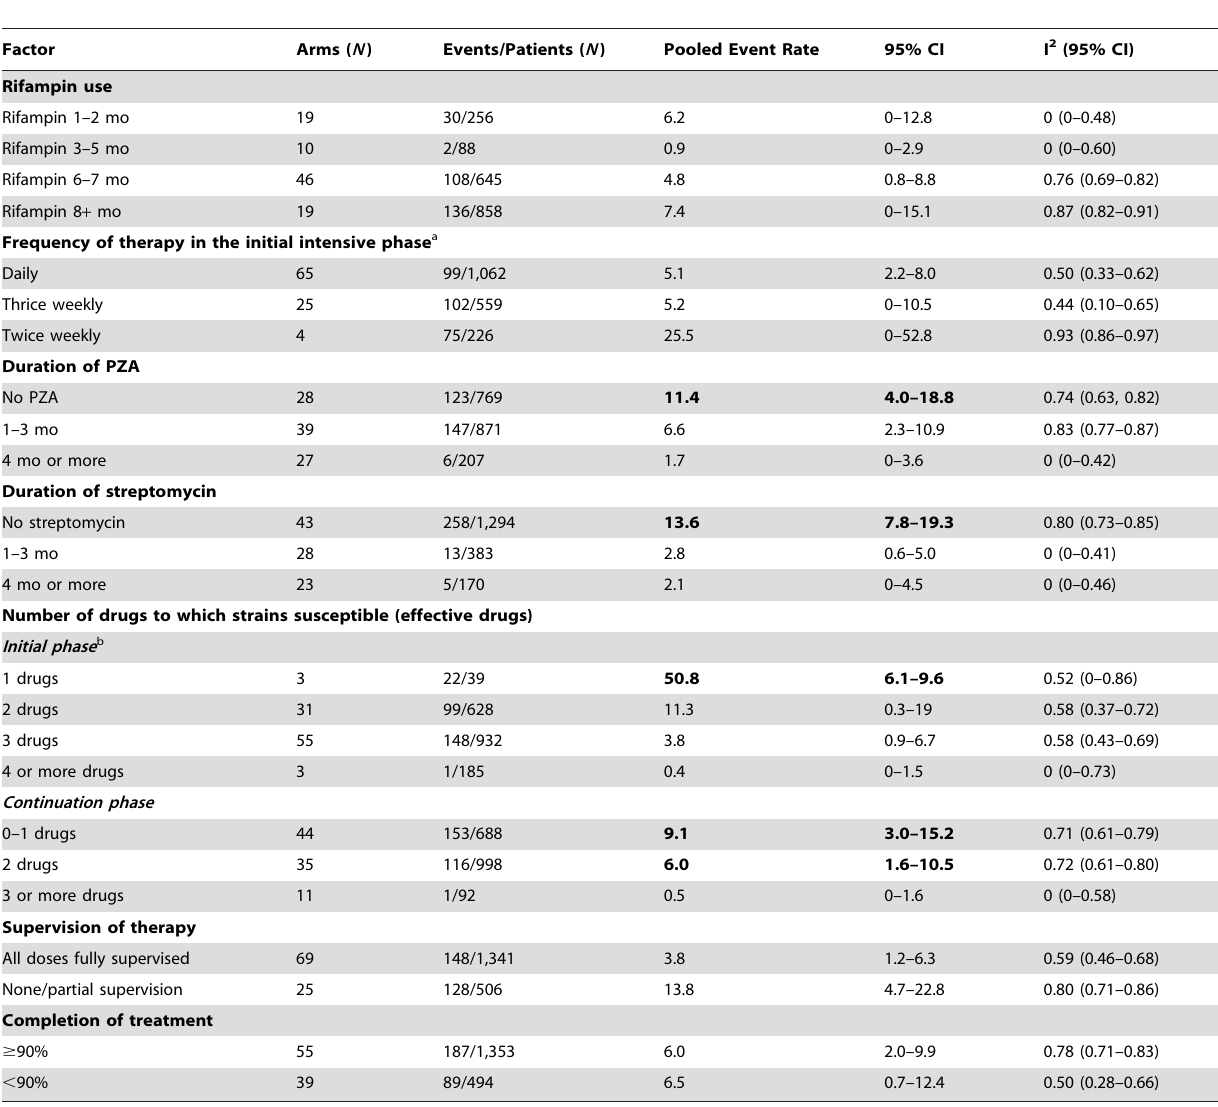
Table 3. Stratified analysis of covariates associated with TB treatment outcomes in RCT of patients with INH resistance in new or previously treated cases: Failure in isoniazid